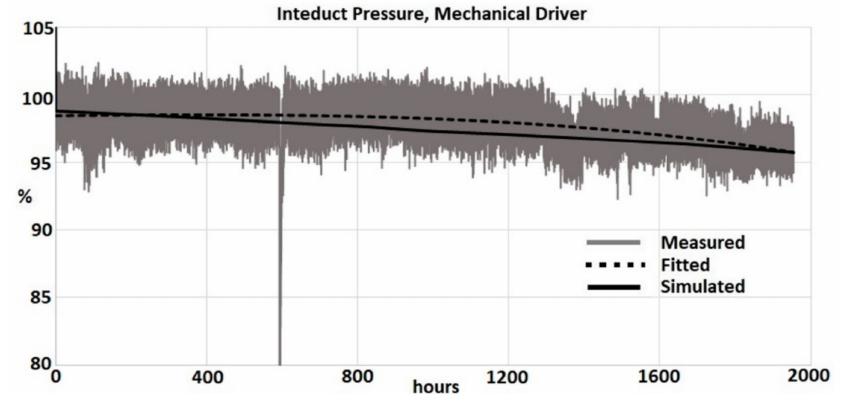
Figure 10. Measured, fitted, and simulated interduct pressures.